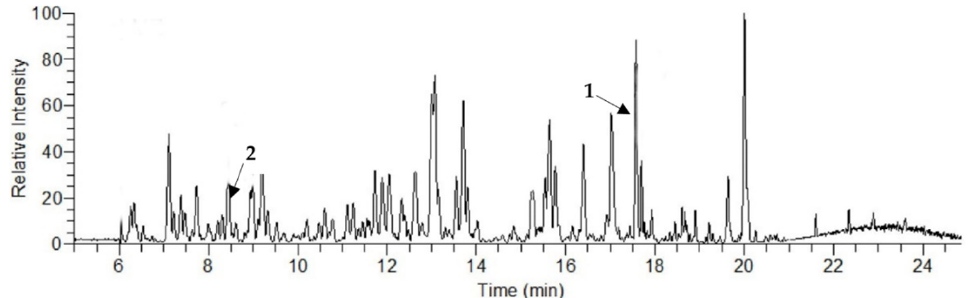
Figure 1. LCMS chromatogram of sugarcane molasses where (1) is diosmin and (2) is chlorogenic acid.